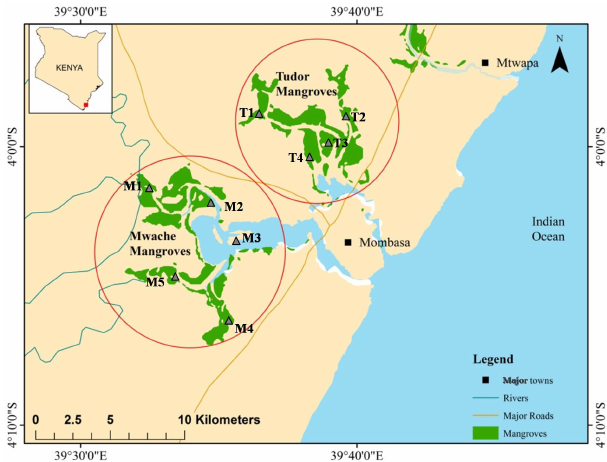
Fig. 1. Map of the study area showing the Mombasa mangroves (Mwache and Tudor creeks): M1, M2, M3, M4 and M5 represent Mashazani, Ngare, KPA, Mwakuzimu and Maguzoni respectively (in Mwache Creek), whereas T1, T2, T3 and T4 represent Jomvu, Kijiwe, Island and Mikindani respectively (in Tudor